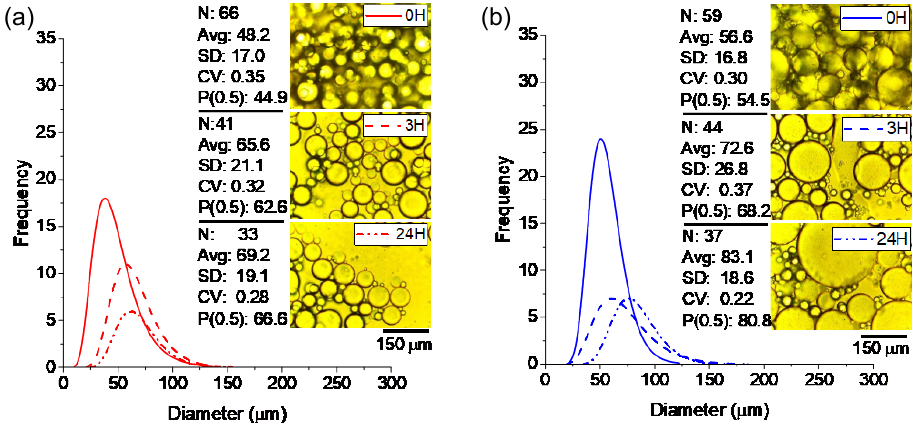
Figure 4. Frequency histograms of the diameter of the droplets fitted to a log-normal distribution(N: number of samples, Avg.: Average value, SD: Standard deviation, CV: coefficient of variation, and P(0.5): 50th percentile for the diameter measurement) and fluorescence microscopy images of the oil droplets at 0h, 3h, and 24h for the O/W emulsions containing: (a) Cooking oil (b) Mineral oil as rejuvenating